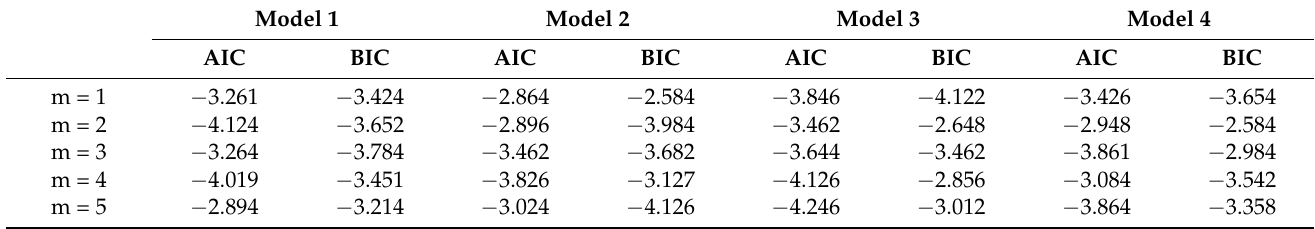
Table 6. Location parameters.